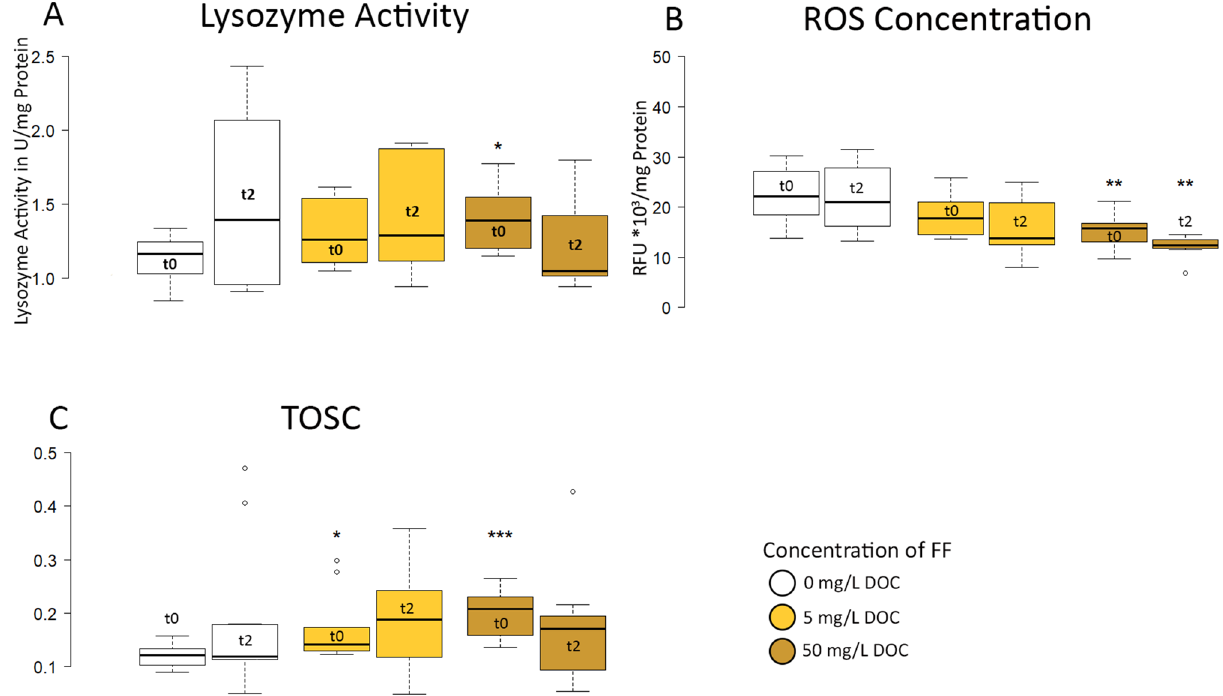
Figure 5. Defense mechanisms in gill supernatant. (A) Lysozyme activity, (B) concentration of reactive oxygen species (ROS), (C) total oxyradical scavenging capacity (TOSC). t0-28 days of exposure; t2-2 days post-stressor (t0). *p < 0.05. **p < 0.01; ***p < 0.001. n =